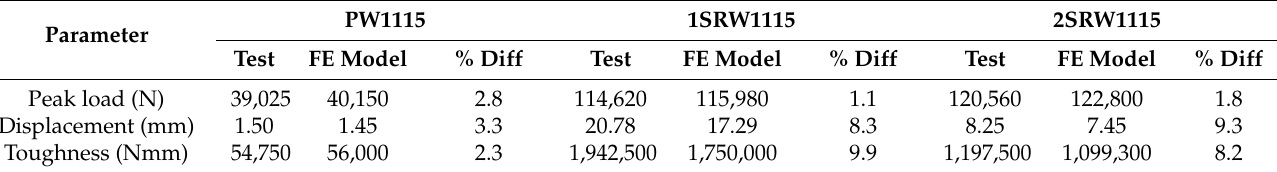
Table 7. Comparison of model and test average